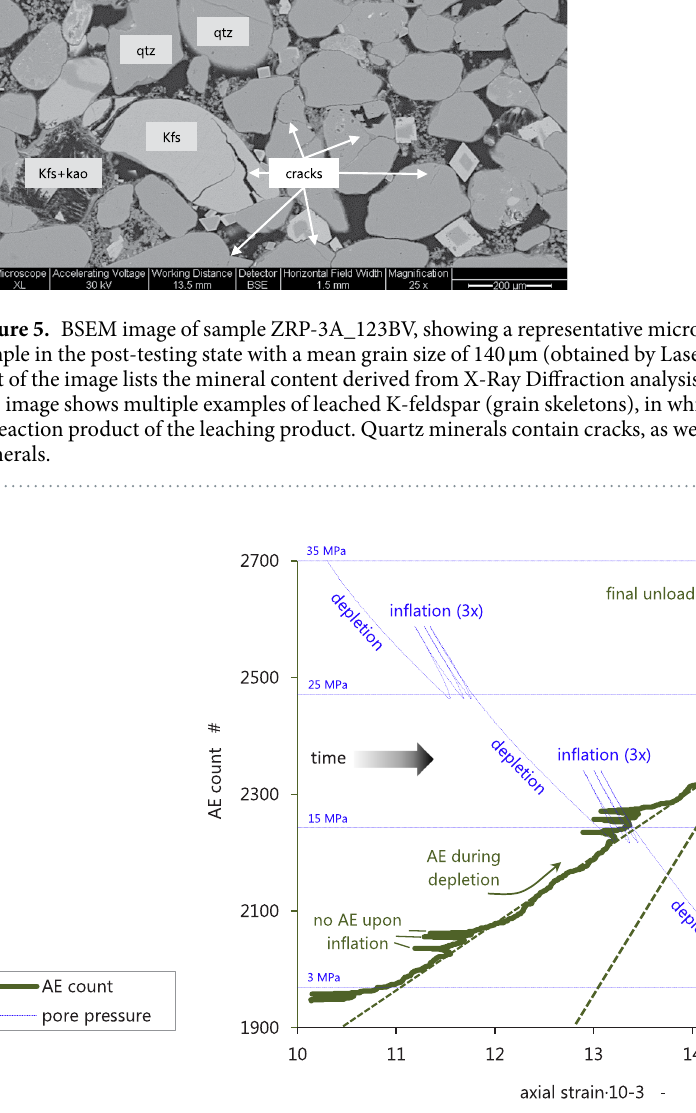
to 10 MPa (Fig. 6). Finally, note that creep during the pore pressure cycle 15 MPa–20 MPa – 15 MPa – results in a deviation from the global AE count versus axial strain trend of 100 counts per 1∙10 − 3 strain. Interdependences of variables by means of statistical modeling. Statistical testing was carried out to quantify the relationships between the stress-strain response measured and the physical controls presented in Sections 2.1 and 2.2. As an initial screening test, univariate linear regression models were used to model each of a number of response variables as a function of a number of potential predictor variables (Table 1). At each depth in the core (‘segment’ hereafter), between one and four samples were collected and used for analysis. Some of the measurements are common to all samples taken at a segment, whereas in general variables may be expected to be more similar within segments than they are between segments. To evaluate the ability of the regression models